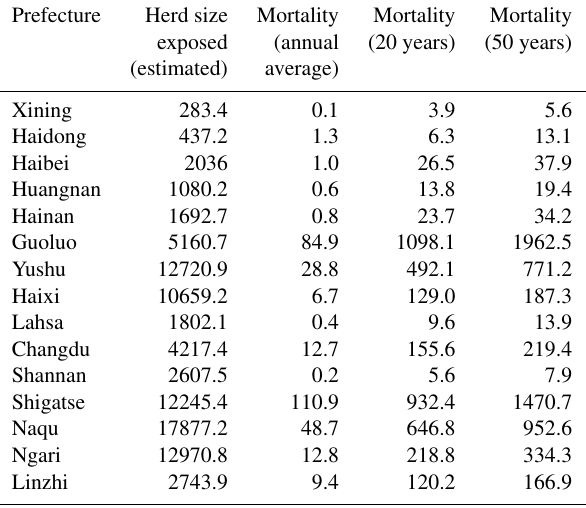
Table 1. Livestock snow disaster risk in terms of mortality (1000 sheep units) by prefecture.